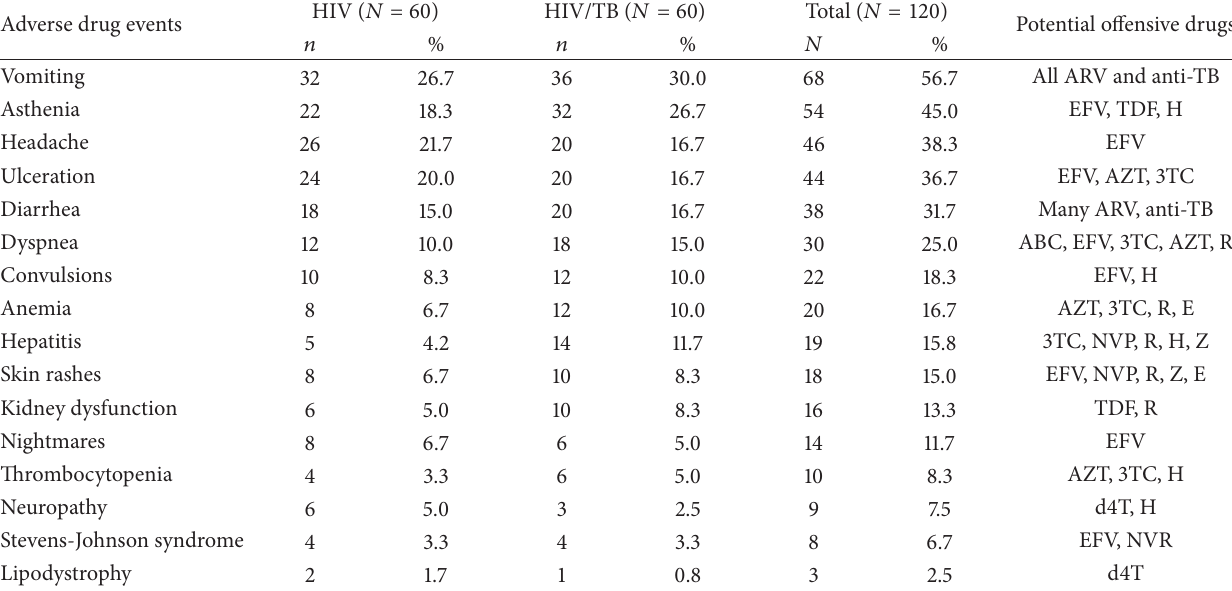
Table 4: Types and frequency of ADEs experienced by